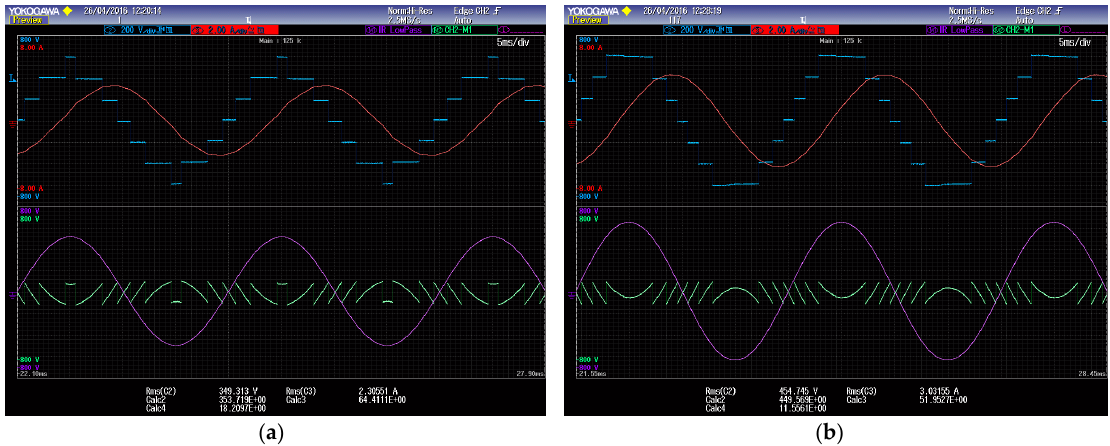
Figure 13. Minimized voltage THD (Figure 10): ( a ) m = 2.45 ( α 1 = 0.119, α 2 = 0.635, α 3 = 1.424); and ( b ) m = 3.19 ( α 1 = 0.155, α 2 = 0.482, α 3 = 0.884).